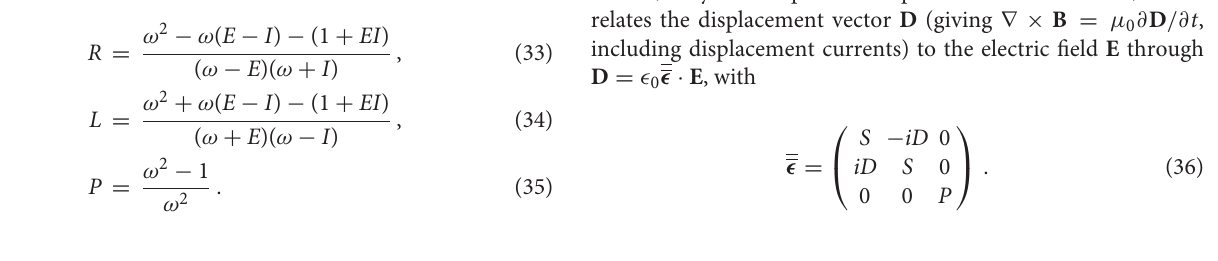
0.1 (top row), 0.5 (bottom left), 2.0 (bottom right). The dashed black circle always = 1.5, as in Figures 2 , 3 , and we exploit the same color scheme: = 2 (bottom = 0.1 =